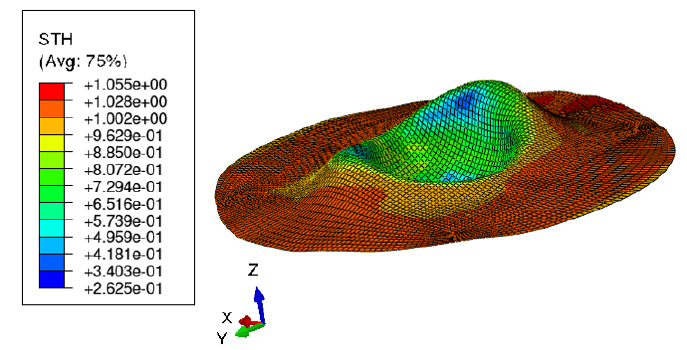
Figure 19. Distribution of shell thickness decreasing at ambient temperature: one-step forming.